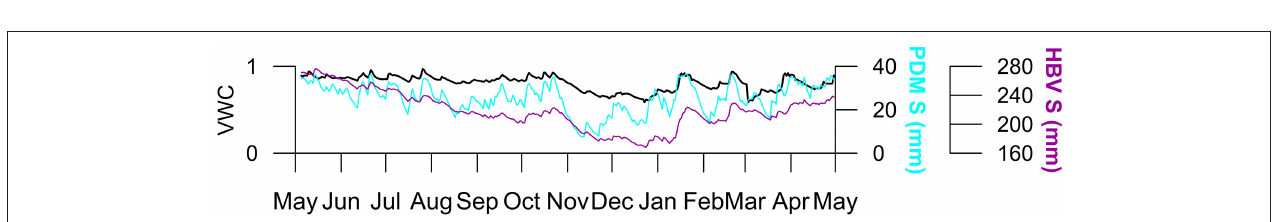
FIGURE 10 | Soil volumetric water content observed with a water content reflectometer (VWC), soil water storage modeled with the PDM (PDM S), and soil water storage modeled with the HBV-light model (HBV